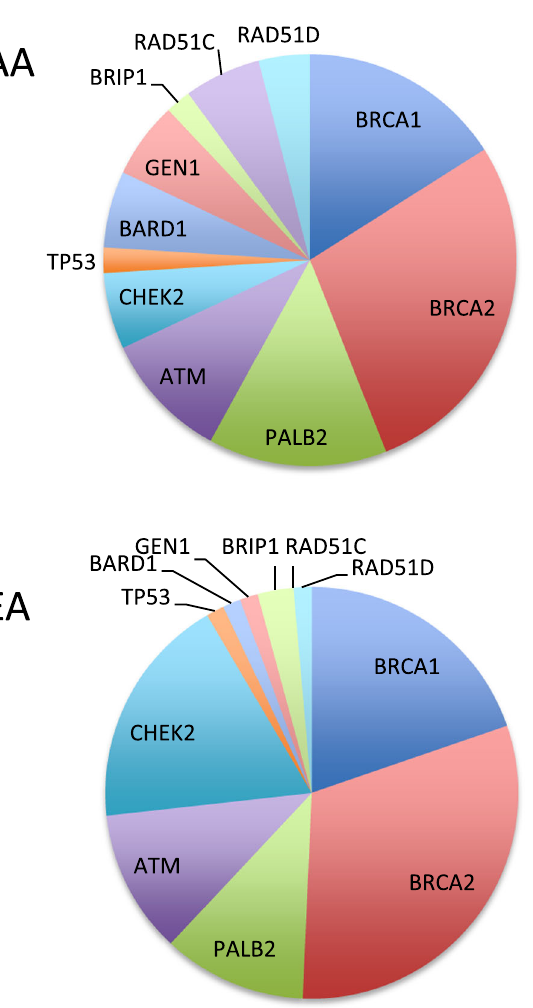
Fig. 1 Genes responsible for inherited breast cancer in the Carolina Breast Cancer Study. The upper panel indicates genes with pathogenic or likely pathogenic mutations in African-American (AA) patients. The lower panel indicates genes with pathogenic or likely pathogenic mutations in European-American (EA)